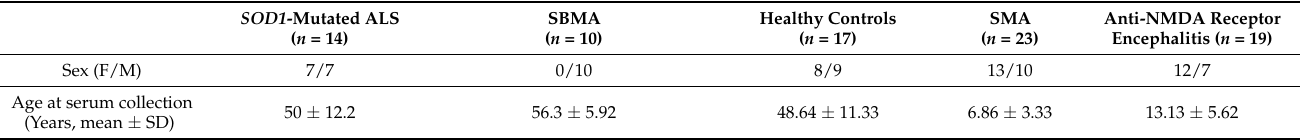
Table 1. Summary of the main features of ALS, SMA, and SBMA patients and controls included in the study. SOD1 -Mutated ALS ( n =